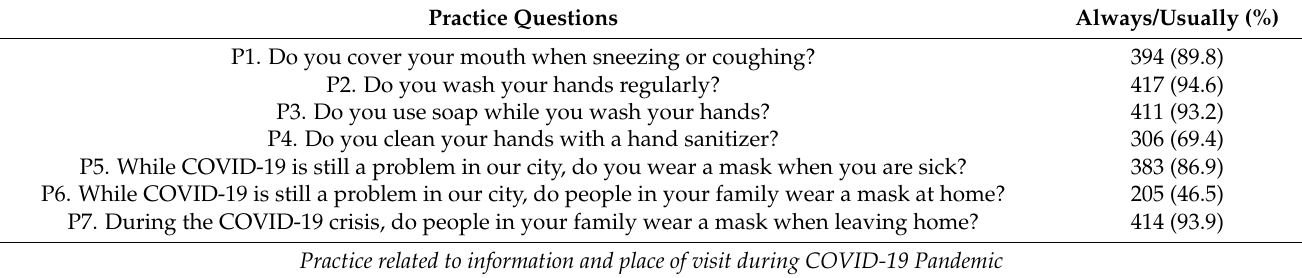
Table 3. Frequency and percentage of participants who opted for “always” or “usually” to the practice items of the questionnaire of the study participants, Phuentsholing Hospital, Bhutan.